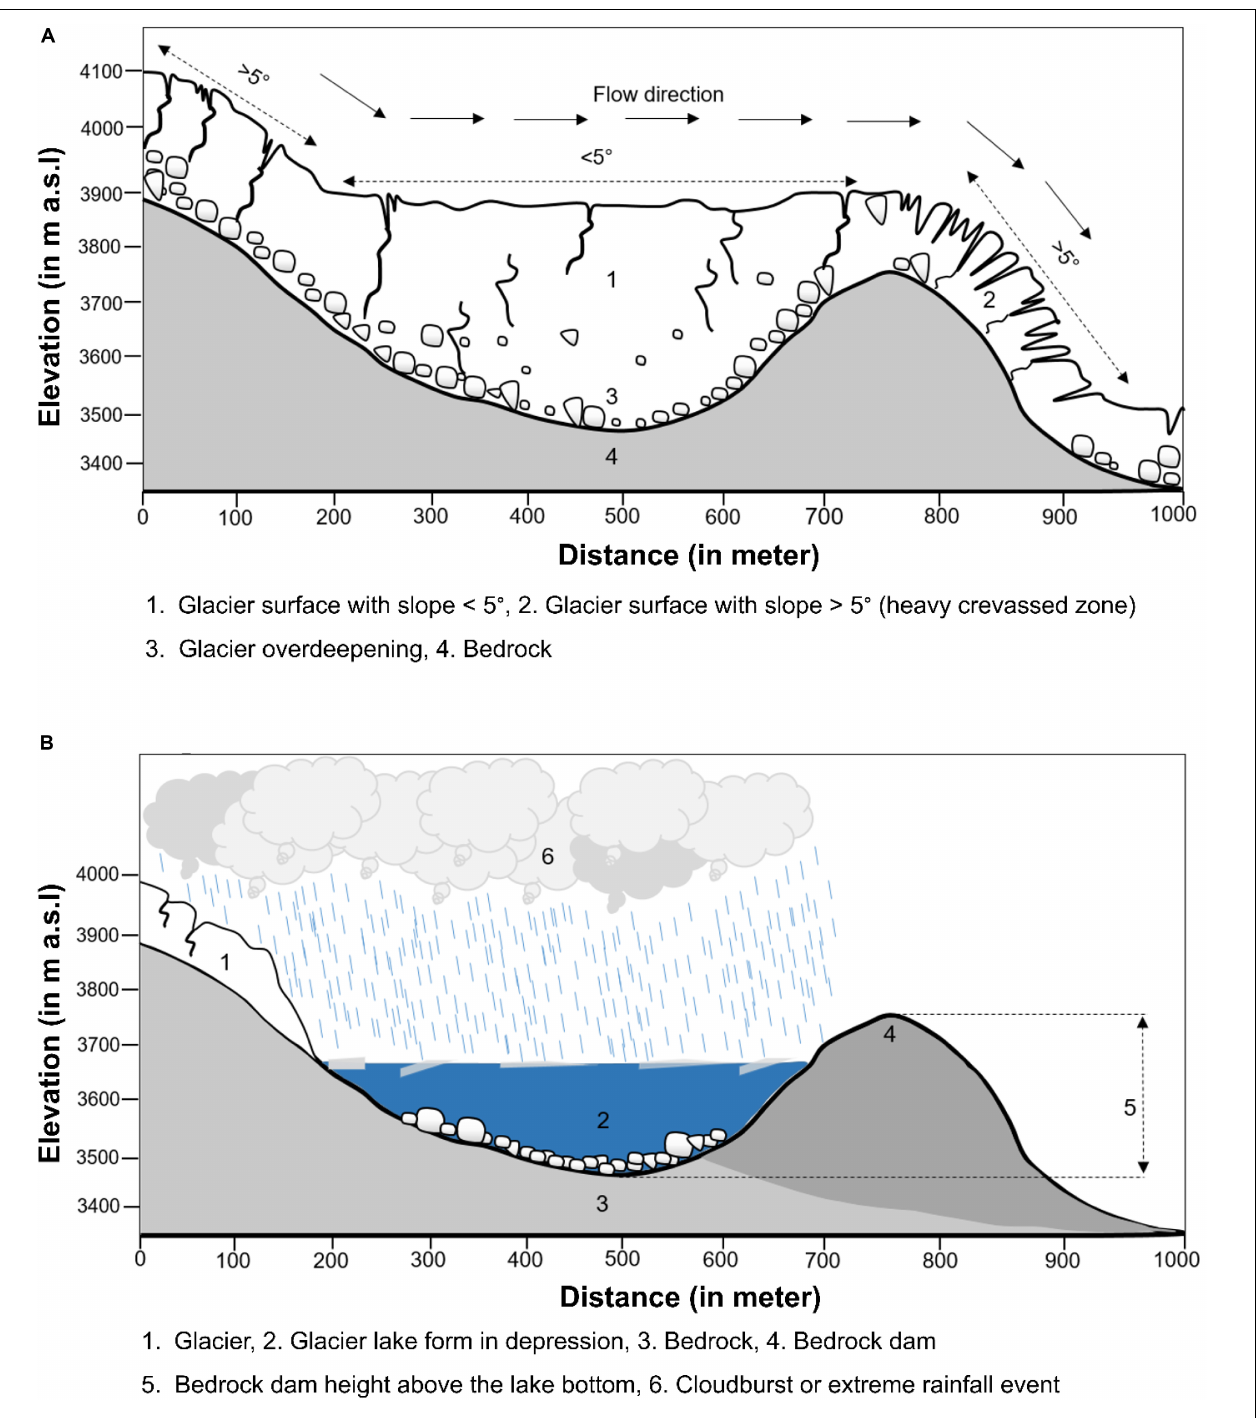
FIGURE 2 | (A) Illustration of a glacier with an overdeepening formed due to glacier flow. (B) Glacier disappearance and formation of the future glacial lake.